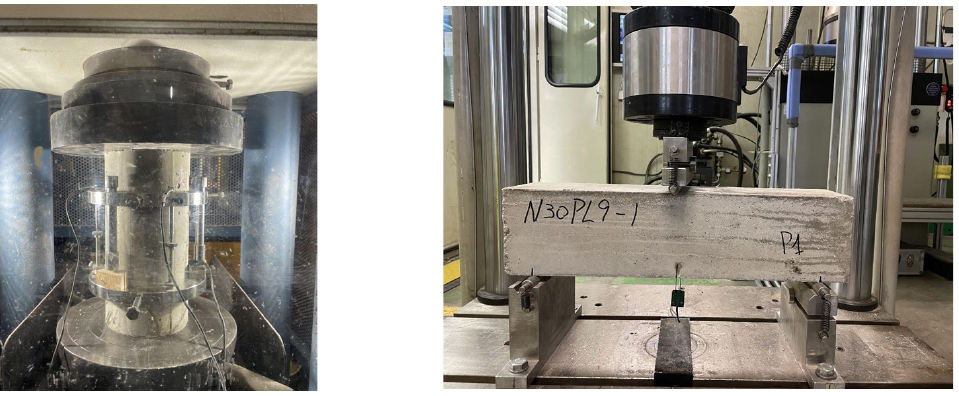
Figure 4. Experimental testing: stress–strain relationship ( left ); residual tensile strength ( right ). The residual flexural tensile strength was tested according to EN 14651 [28]. The Servohydraulic Test System (Instron 8505) was used. For all prisms, a notch of 12.5 mm depth was cut in the middle of the specimen. The test layout of the specimens is shown in Figure 4. The loading speed was 0.05 mm/min until the crack mouth opening displacement (CMOD) reached 0.1 mm, and 0.2 mm/min thereafter, until the CMOD value reached 4 mm and the test was stopped. To calculate the limit of proportionality f LOP and the residual flexural tensile strength f R,j for CMODs of 0.5, 1.5, 2.5, and 3.5 mm, Equation (1) was